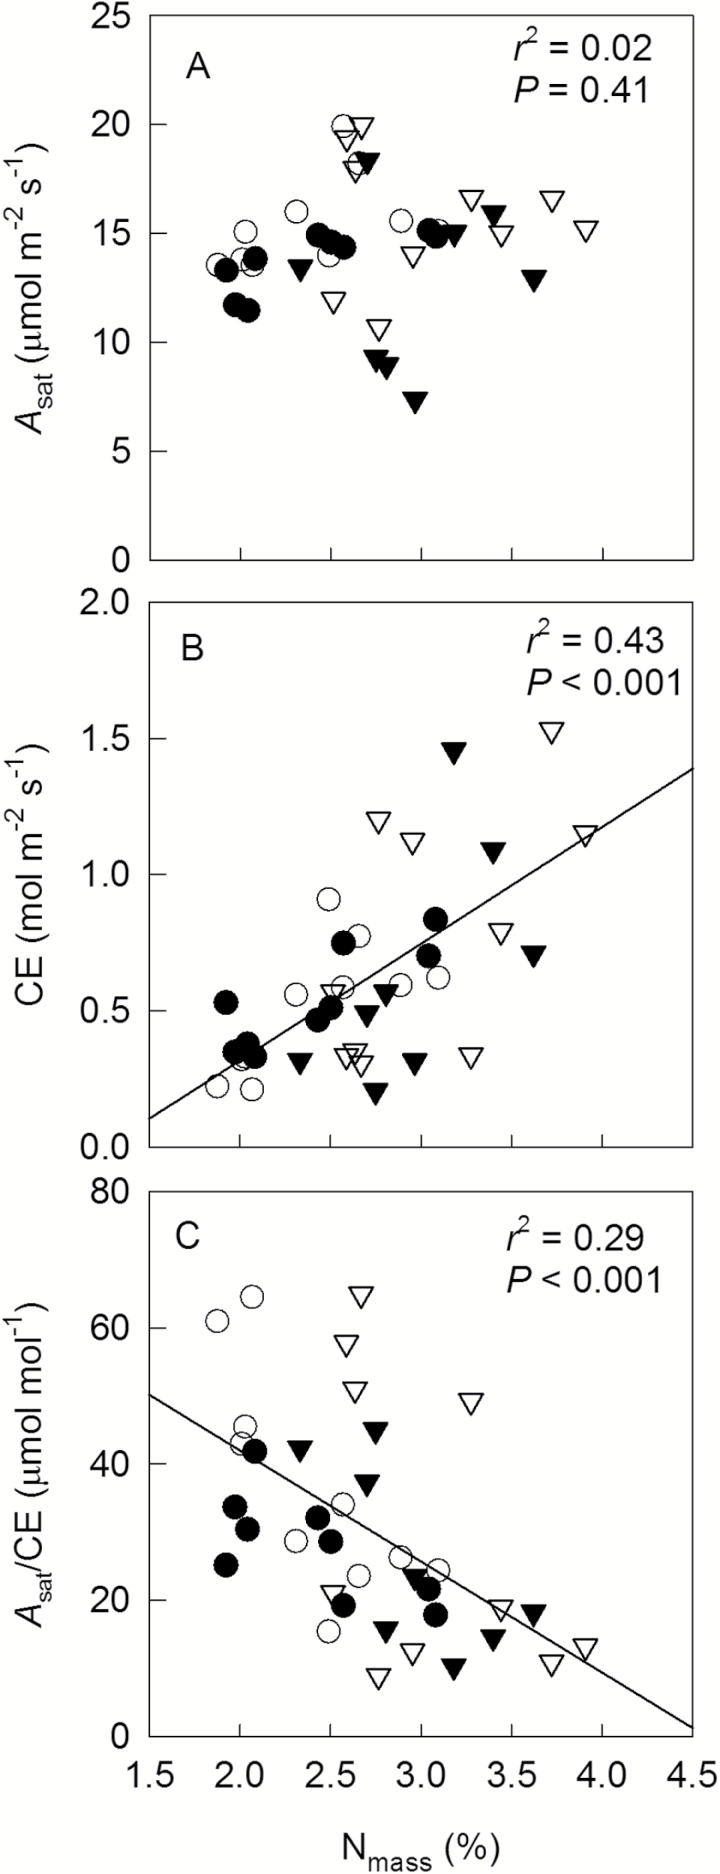
Correlations between Nmass and Asat (A), CE (B) and Asat/CE (C) of leaves grown at low or high N fertilizer supply (N1, circles; or N2, triangles) combined with low or high VPD (V1, open symbols; or V2, filled symbols). Each symbol represents a data point of an individual plant.